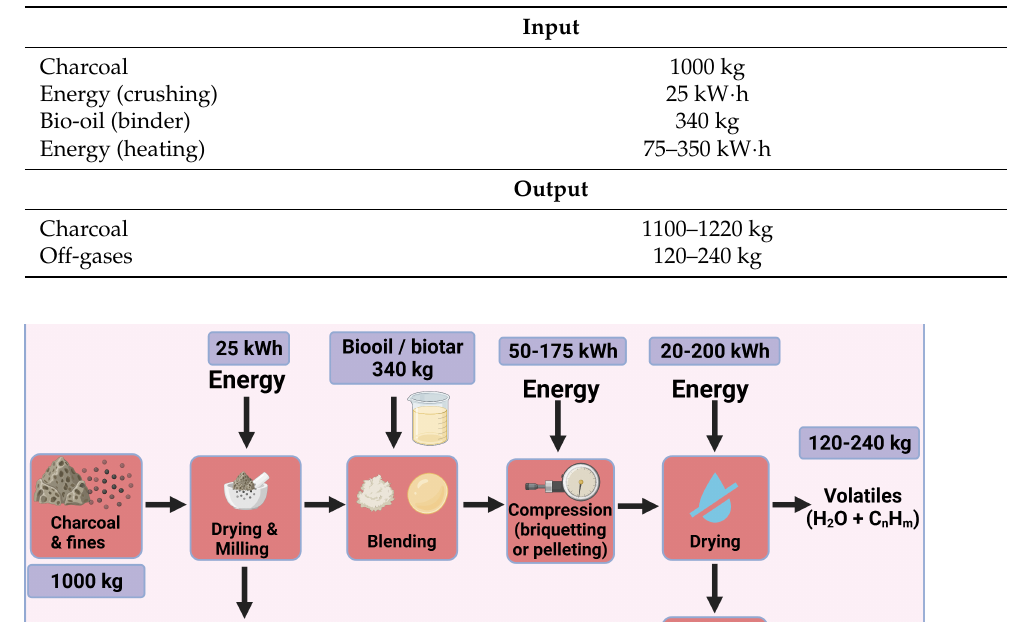
Table 4. Input parameter used for charcoal compaction.